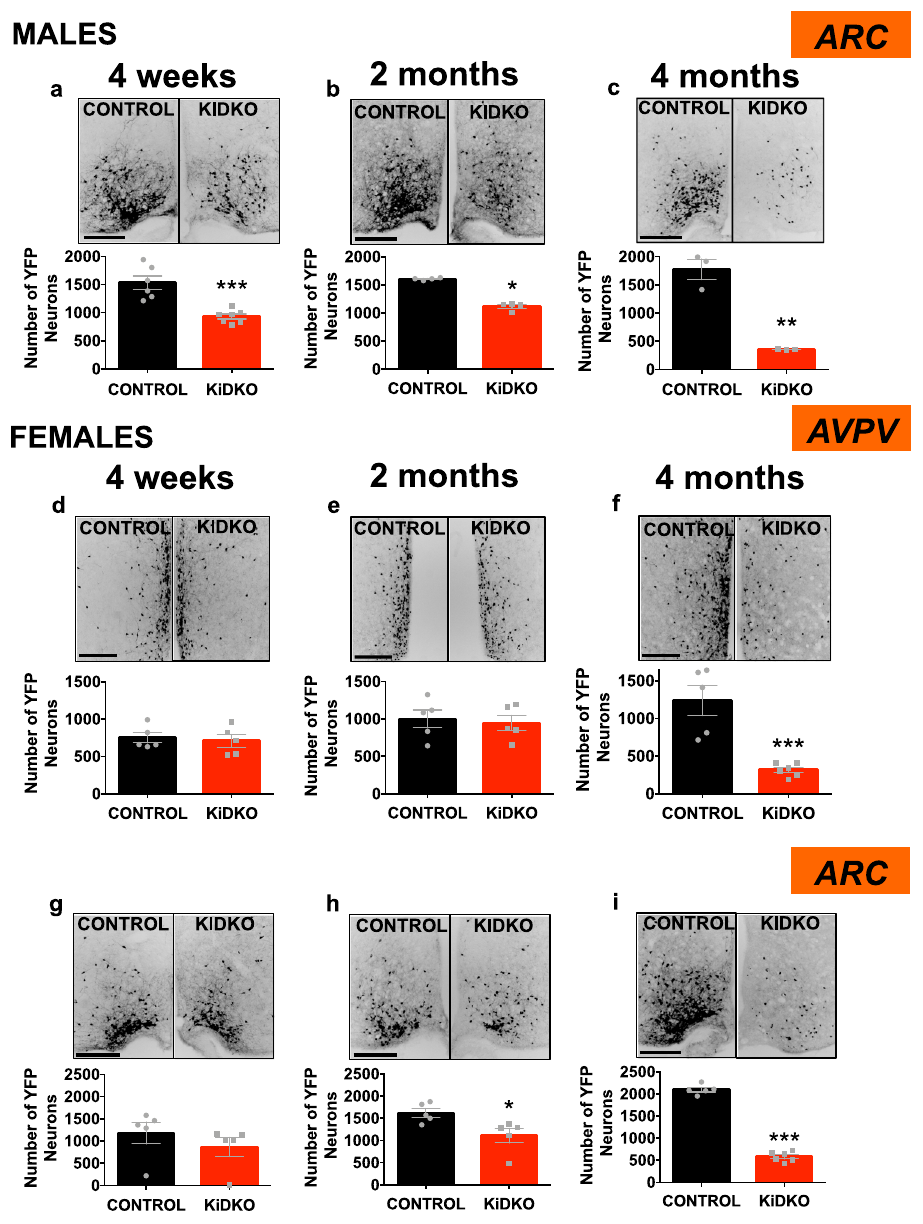
Fig. 6 | Kiss1 neuronal survival in the hypothalamus of KiDKO mice along postnatal maturation. Labeling of viable Kiss1 neurons in vivo was achieved by using a triple transgenic mouse line, expressing the Cre-dependent reporter (ROSA26)-YFP inKiss1 neuronsupon aKiDKObackground.Inthismouse line,cells everexpressingKiss1becomepersistentlylabeledwiththe fl uorescentmarkerYFP, even if they stop expressing Kiss1. Representative images and quantitative data on YFP-positive cells in the ARC of males ( a – c ) and the AVPV ( d – f ) and ARC ( g – i ) of females of control and KiDKO genotypes are presented. Data were collected at